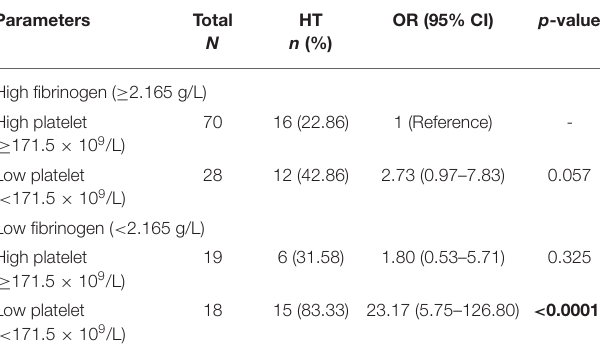
HT OR (95% CI) p -value N n (%)